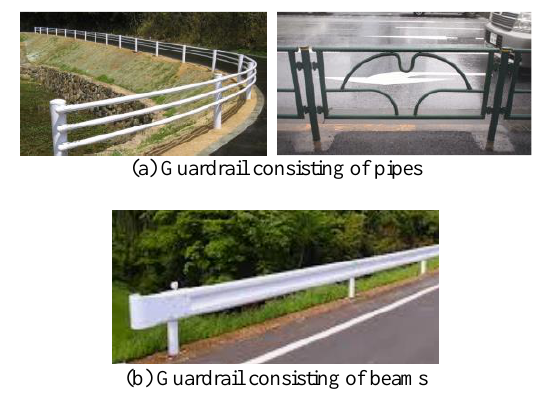
Figure 2. Various types of